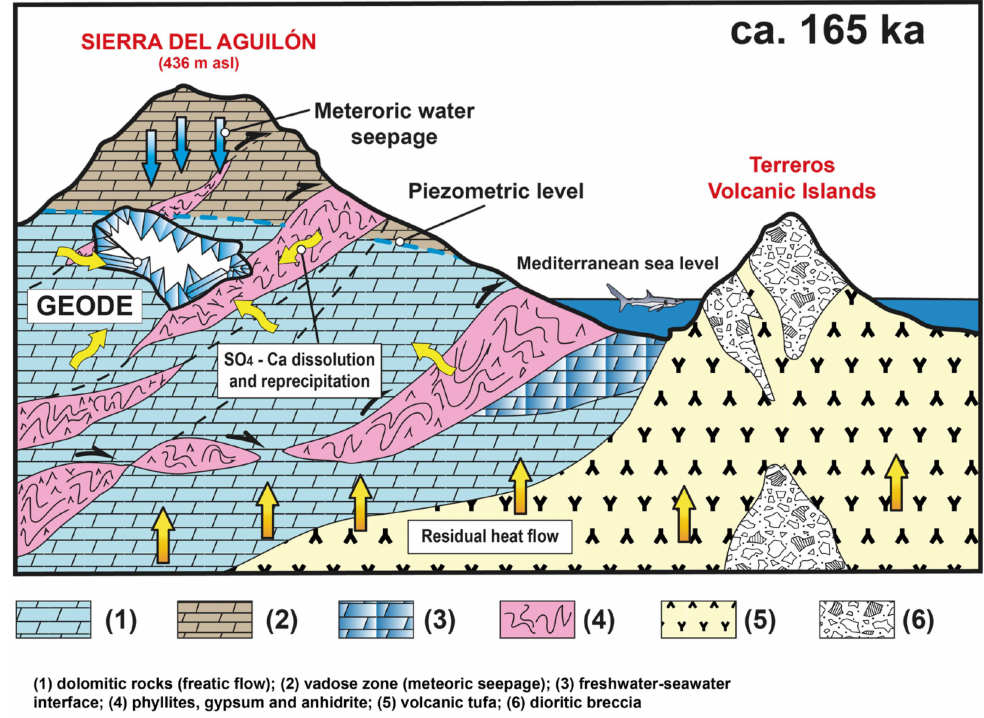
Figure 3. Conceptual sketch of gypsum precipitation in the Giant Geode of Pulp í from at least 164 ± 15 ka to sometime before 60 ka. Our results of stable isotopes in gypsum hydration water suggest a prevailing source of sulfate-enriched water from the paleo-aquifer, with the sea level located below the Geode level (currently at 97 m asl). Meteoric water seepage that recharged the aquifer and the solution from which the gypsum crystals were formed was freshwater, with insignificant contributions of seawater. Dissolution of Triassic gypsum and anhydrite associated to phyllites was the main source of sulfate to the solution. Note that the scale is exaggerated and a precise topography omitted for a better